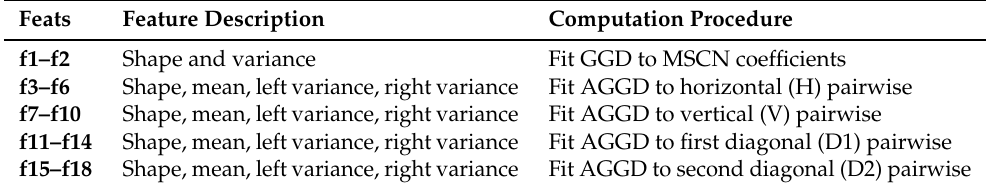
Table 1. Extracted features based on NSS in spatial